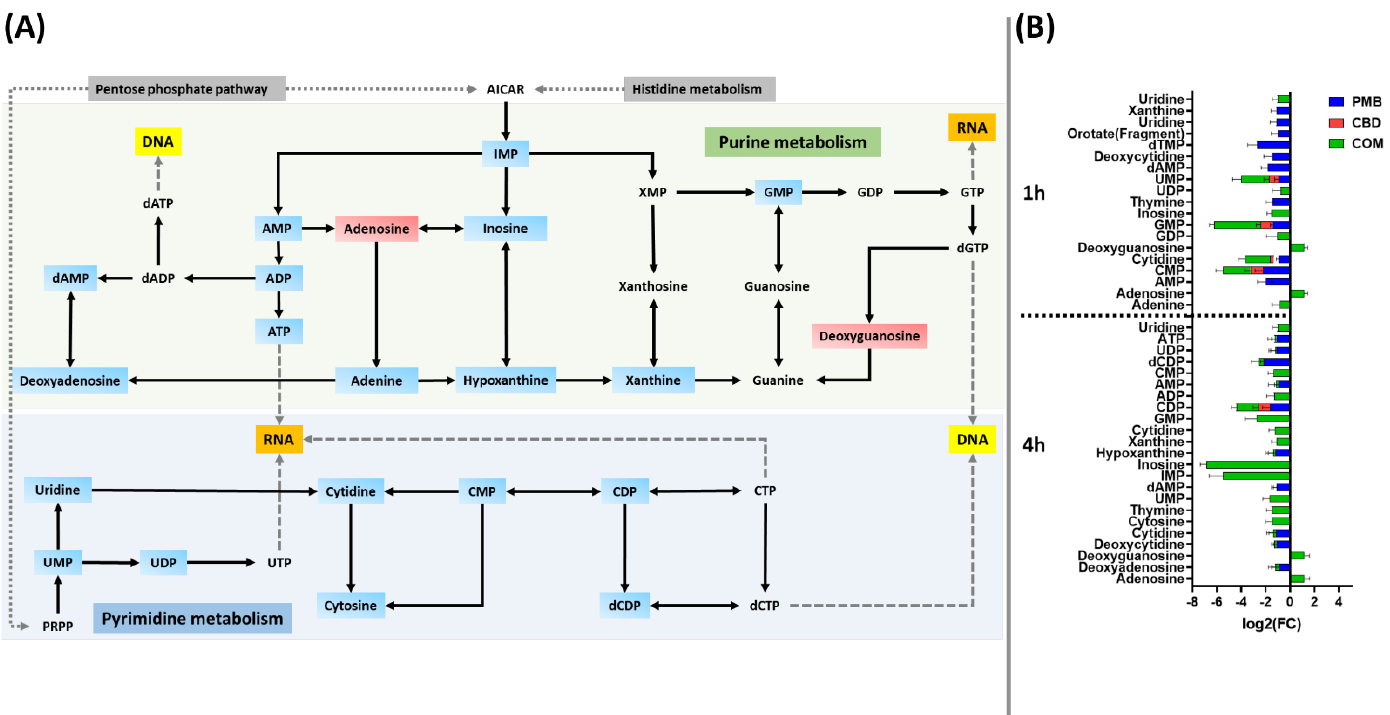
Figure 4. ( A ) Graph showing the impacted pyrimidine and purine metabolism for A. baumannii ATCC 19606 after 4 h treatment with polymyxin B (PMB), cannabidiol (CBD) and their combination (COM). ( B ) Bar charts for the significantly impacted metabolites of pyrimidine and purine metabolism after treatment with polymyxin B (PMB) or cannabidiol (CBD) monotherapy and their combination (COM) at 1 and 4 h ( ≥ 0.59-log 2 -fold, p ≤ 0.05). Blue rectangles: significantly inhibited metabolites; Red rectangles: Significantly increased metabolites.